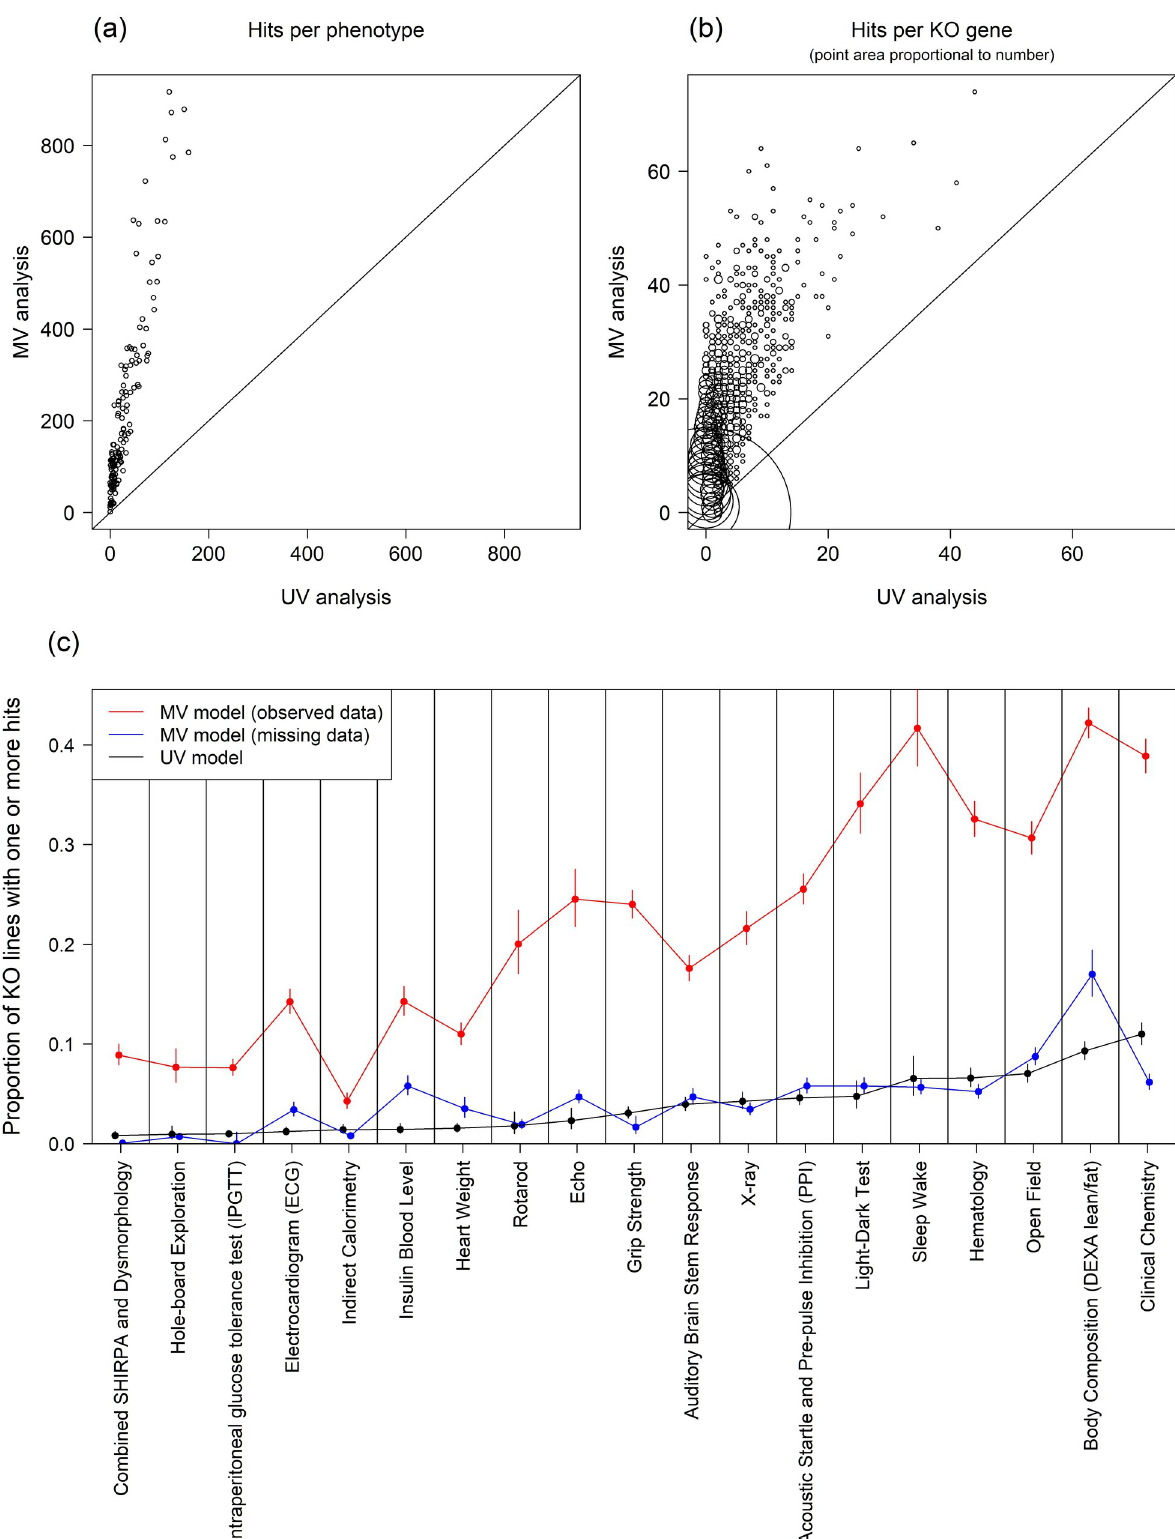
Fig 5. Power enhancement: The MV method offers increased sensitivity to detect gene-KO-induced perturbations. (a) Number of perturbations per phenotype identified by MV vs. UV models. (b) Number of perturbations per KO line identified by MV vs. UV models. (c) The proportion of lines with at least 1 hit in a procedure (i.e., having at least 1 phenotype perturbed in that procedure) is used to compare the power of the UV method